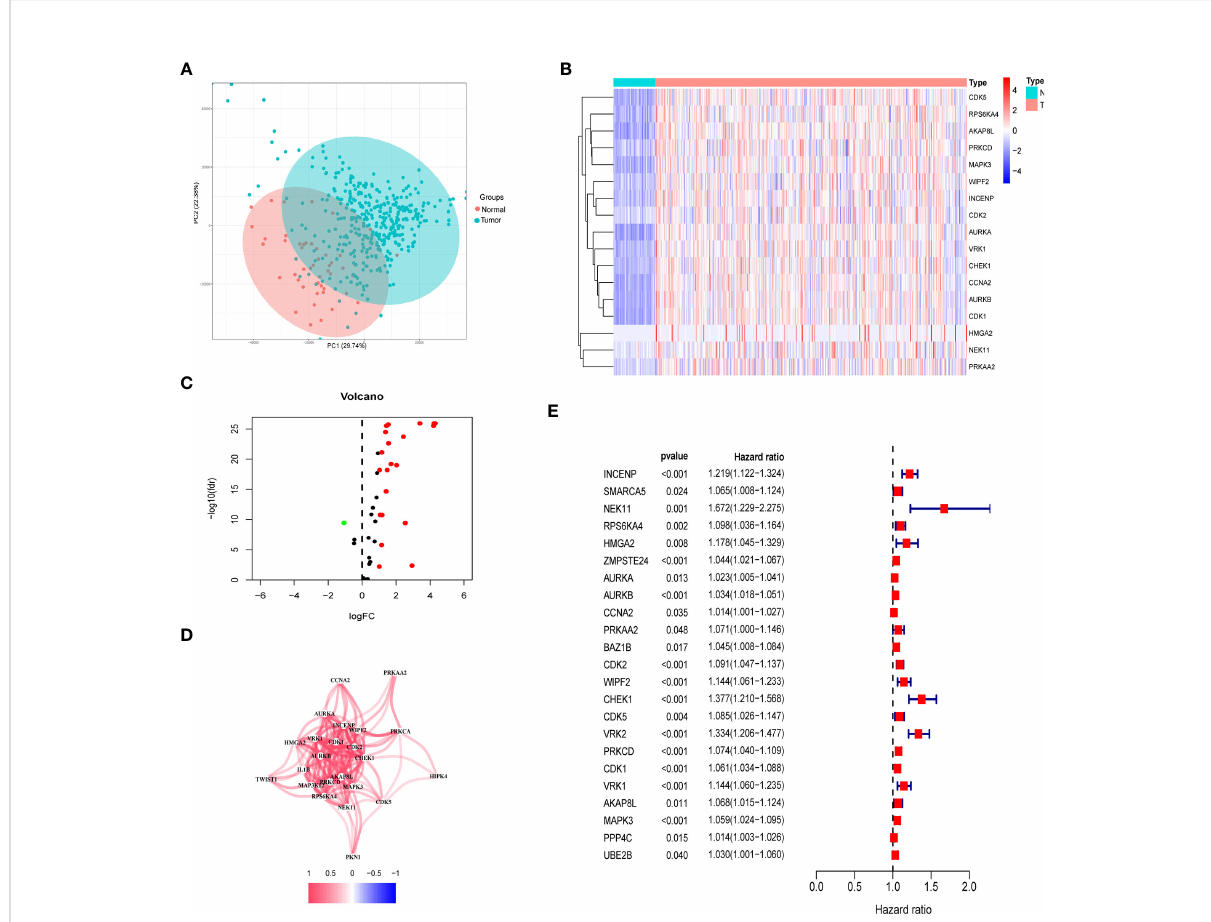
FIGURE 2 Identi fi cation of prognostic histone phosphorylation-related genes in the TCGA cohort. (A) PCA of normal and tumor samples. (B) The heatmap of DE-HPGs in the TCGA cohort; N represent normal and T represent tumor. (C) The volcano-plot of DE-HPGs; red denotes up-modulated genes and blue denotes down-modulated genes. (D) The correlation network of candidate genes. (E) Univariate Cox regression analysis identi fi ed prognostic variables for HR with 95% CI and P-value. PCA, principal component analysis; DE-HPGs, differentially expressed histone phosphorylation-related